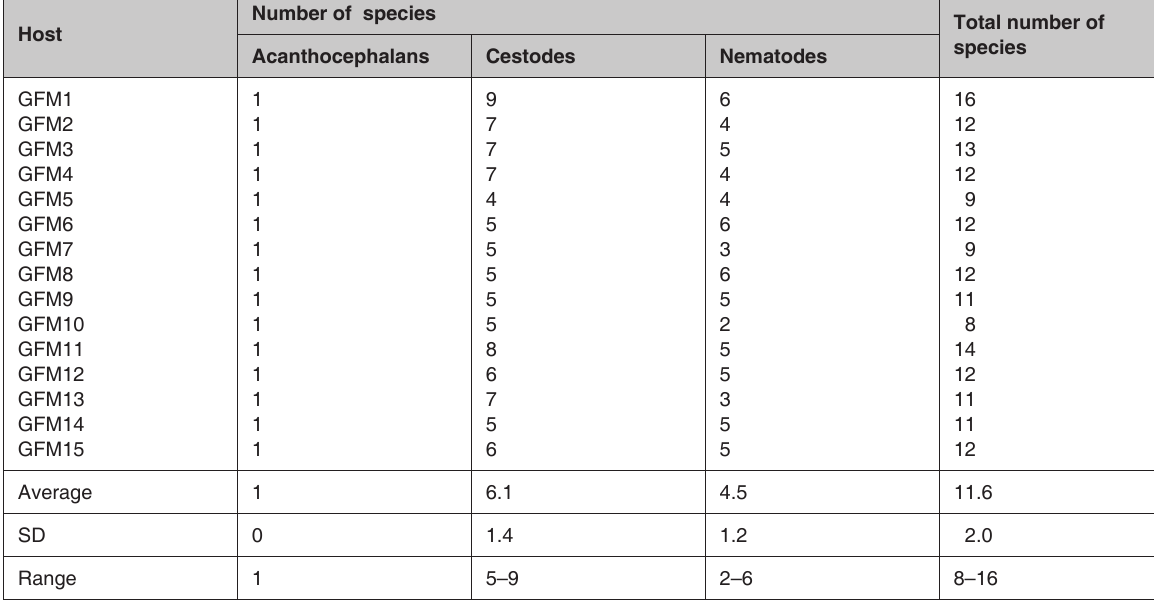
FIG. 2 The frequency distribution of the total number of hel- minths in individual Helmeted Guineafowls in Musina. Helminth burdens were grouped into size classes (0– 400, 401–800, etc. to 2 000+ helminths per guinea fowl) represented on the x-axis. The y-axis displays the num- ber of guineafowls infected with a certain size class of helminth